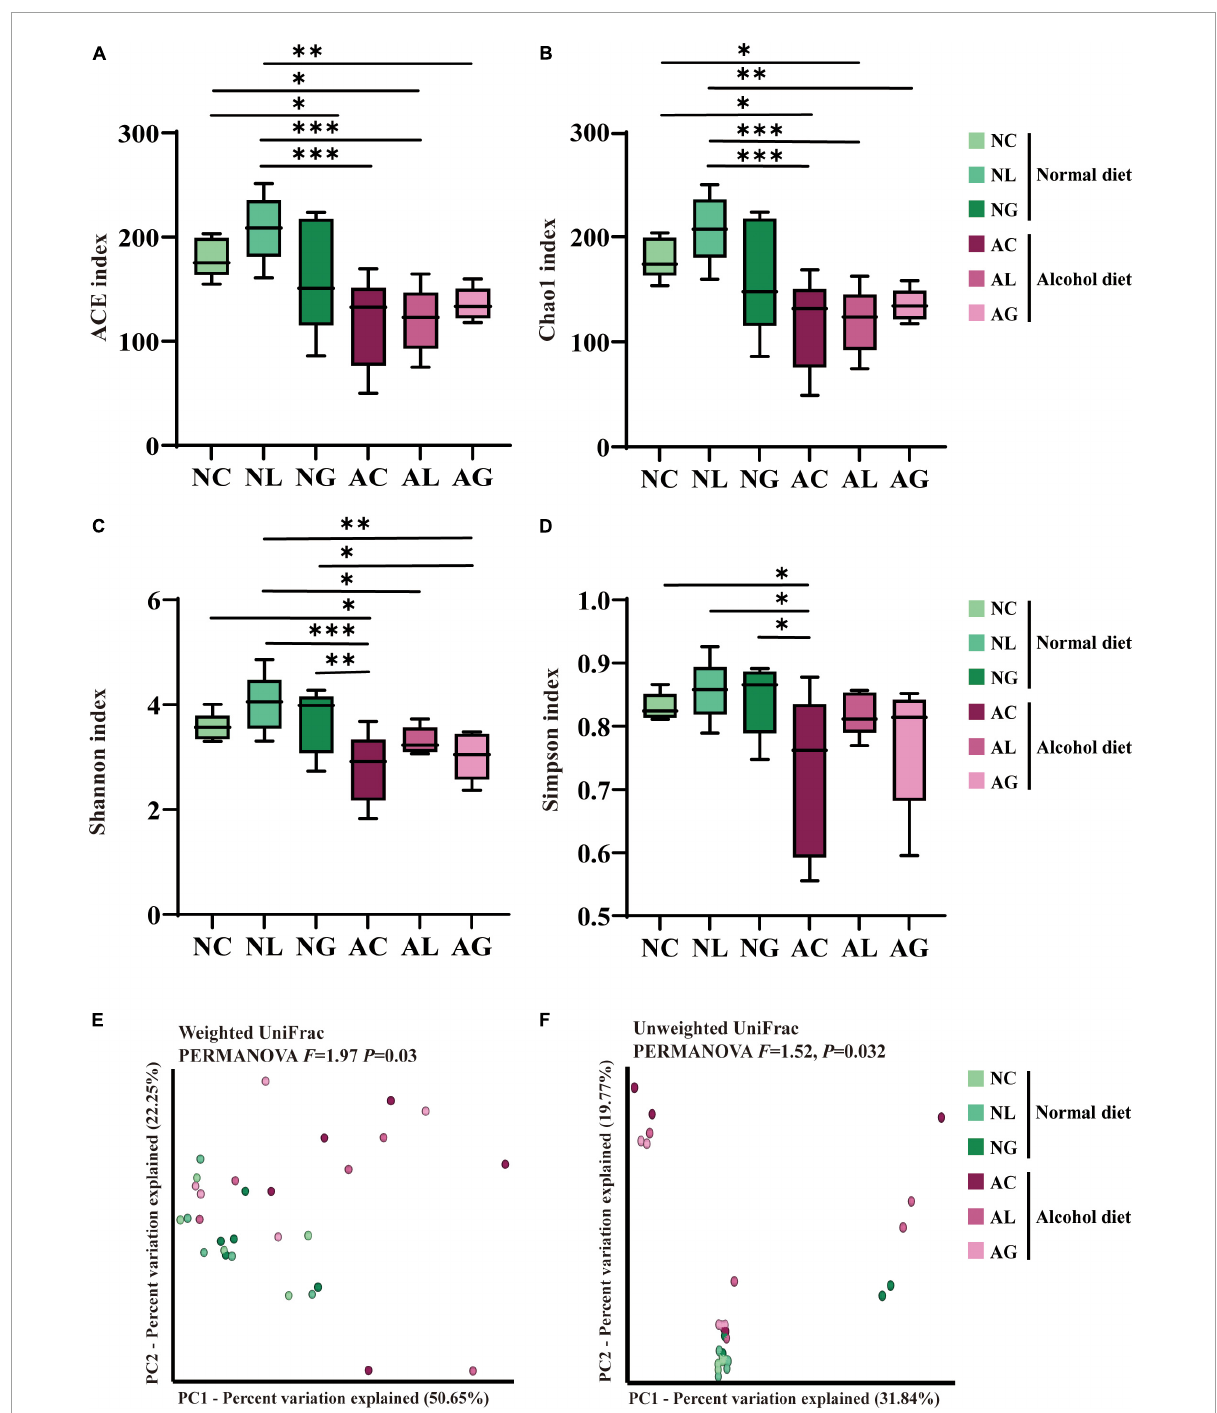
FIGURE4 Effect of LAB intake on gut microbial alpha- and beta-diversity in normal and alcohol diet-fed mice. The (A) ACE and (B) Chao1 indices indicate ASV richness, while the (C) Shannon and (D) Simpson indices indicate ASV evenness in the mice fecal samples. The boxes represent the interquartile range between the 25th and 75th percentile, and the horizontal line inside the box denotes the median. The data were analyzed by performing ordinary one-way ANOVA followed by Fisher’s LSD test. Data are expressed as mean ± standard error of mean (SEM), ∗ p < 0.05, ∗∗ p < 0.01, ∗∗∗ p < 0.001. The principal coordinates analysis (PCoA) plot was constructed using (E) Weighted and (F) Unweighted UniFrac distance matrices. The data were analyzed via PERMANOVA using 999 permutations. NC, normal diet group; NL, normal diet and Lactiplantibacillus ( Lp .) plantarum DSR J266 + Levilactobacillus ( Lv .) brevis DSR J266 group; NG, normal diet and Lacticaseibacillus ( Lb .) rhamnosus GG group; AC, alcohol diet group; AL, alcohol diet and Lp . plantarum DSR J266 + Lv . brevis DSR J301 group; AG, alcohol diet, and Lb. rhamnosus GG group; LSD, least significant